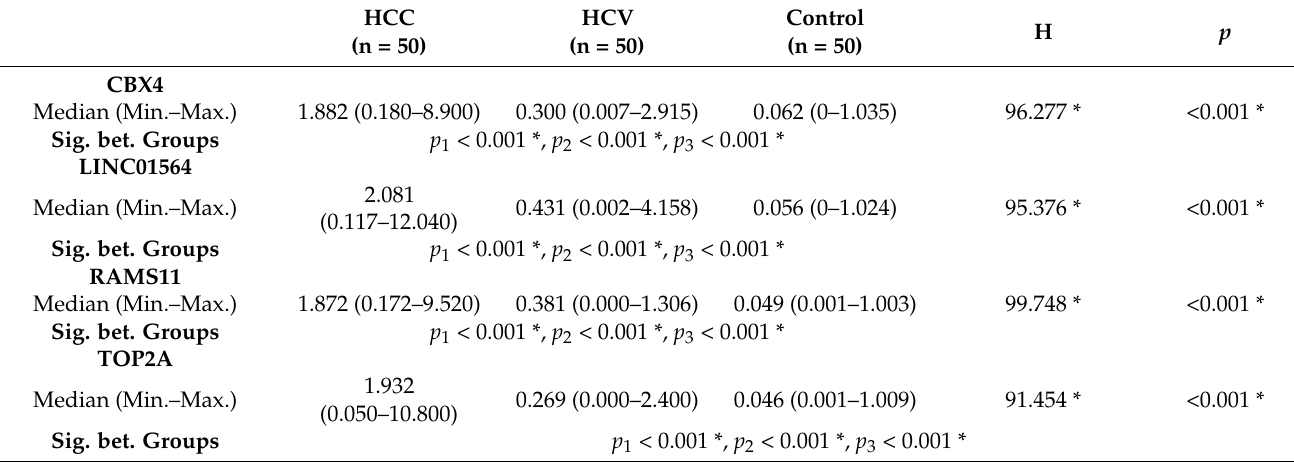
Table 3. Long noncoding RNAs (LNCRNAs) in the three studied